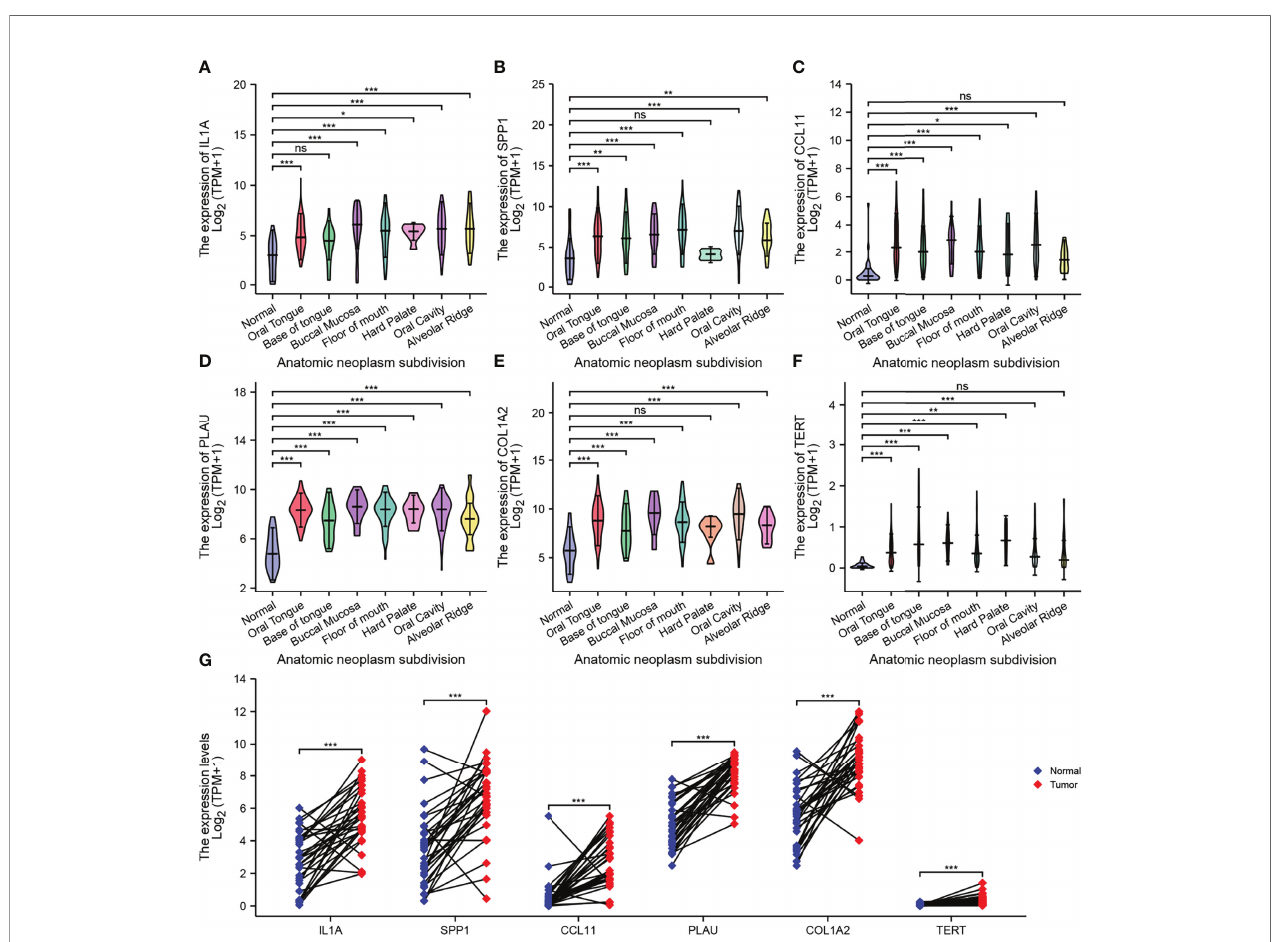
FIGURE 4 | Expression of AFOC-DEGs in OSCC compared with normal tissues. (A) Differential expression of IL1A in OSCC of various parts of the oral cavity; a rank-sum test was used to analyze the data (n = 328, *p < 0.05; ***p < 0.001; ns, not signi fi cant). (B) Differential expression of SPP1 in OSCC of various parts of the oral cavity; a rank-sum test was used to analyze the data (n = 328, **p < 0.01; ***p < 0.001; ns, not signi fi cant). (C) Differential expression of CCL11 in OSCC of various parts of the oral cavity; a rank-sum test was used to analyze the data (n = 328, *p < 0.05; ***p < 0.001; ns, not signi fi cant). (D) Differential expression of PLAU in OSCC of various parts of the oral cavity; a rank-sum test was used to analyze the data (n = 328, ***p < 0.001). (E) Differential expression of COL1A2 in OSCC of various parts of the oral cavity; a rank-sum test was used to analyze the data (n = 328, ***p < 0.001; ns, not signi fi cant). (F) Differential expression of TERT in OSCC of various parts of the oral cavity; a rank-sum test was used to analyze the data (n = 328,**p < 0.01; ***p < 0.001; ns, not signi fi cant). (G) Differential expression of AFOC-DEGs in OSCC and para-cancer tissues; a paired rank-sum test was used to analyze the data (n = 328, ***p < 0.001). DEGs, differentially expressed genes; OSCC, oral squamous cell